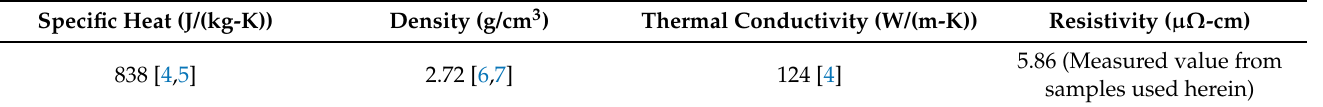
Table 1. Material properties of AA7075 used in thermal simulation.